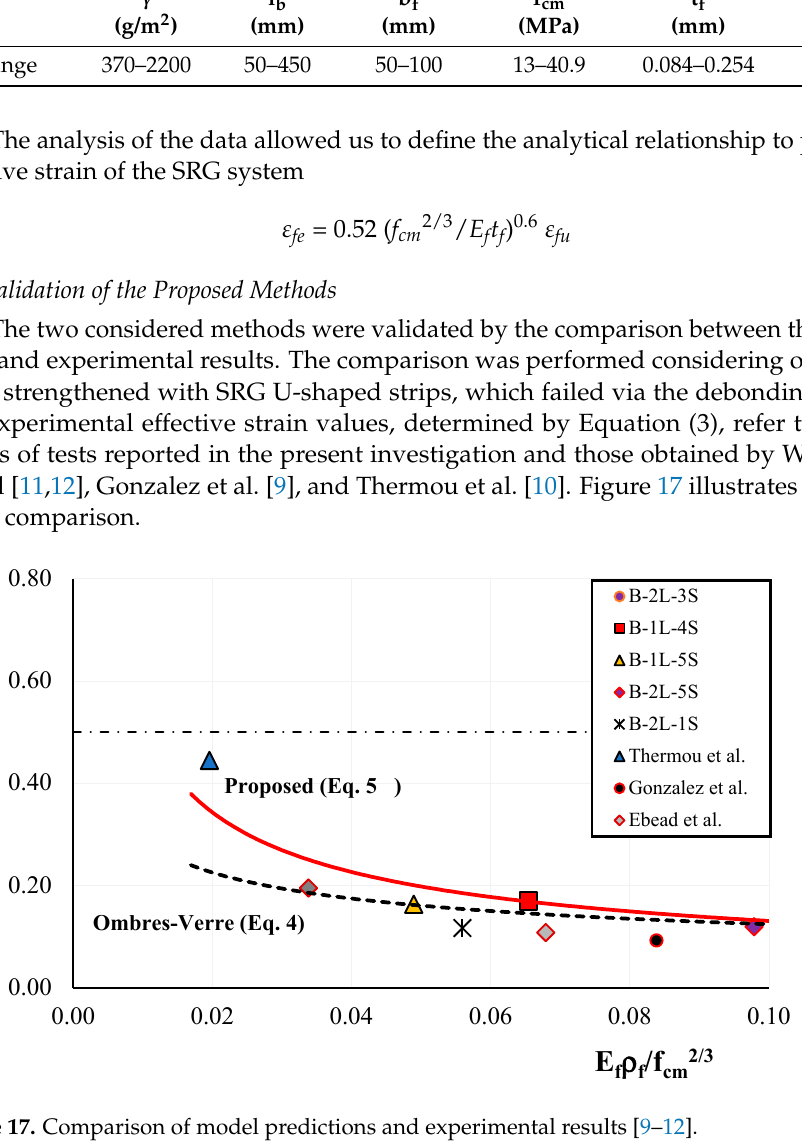
Figure 17. Comparison of model predictions and experimental results.